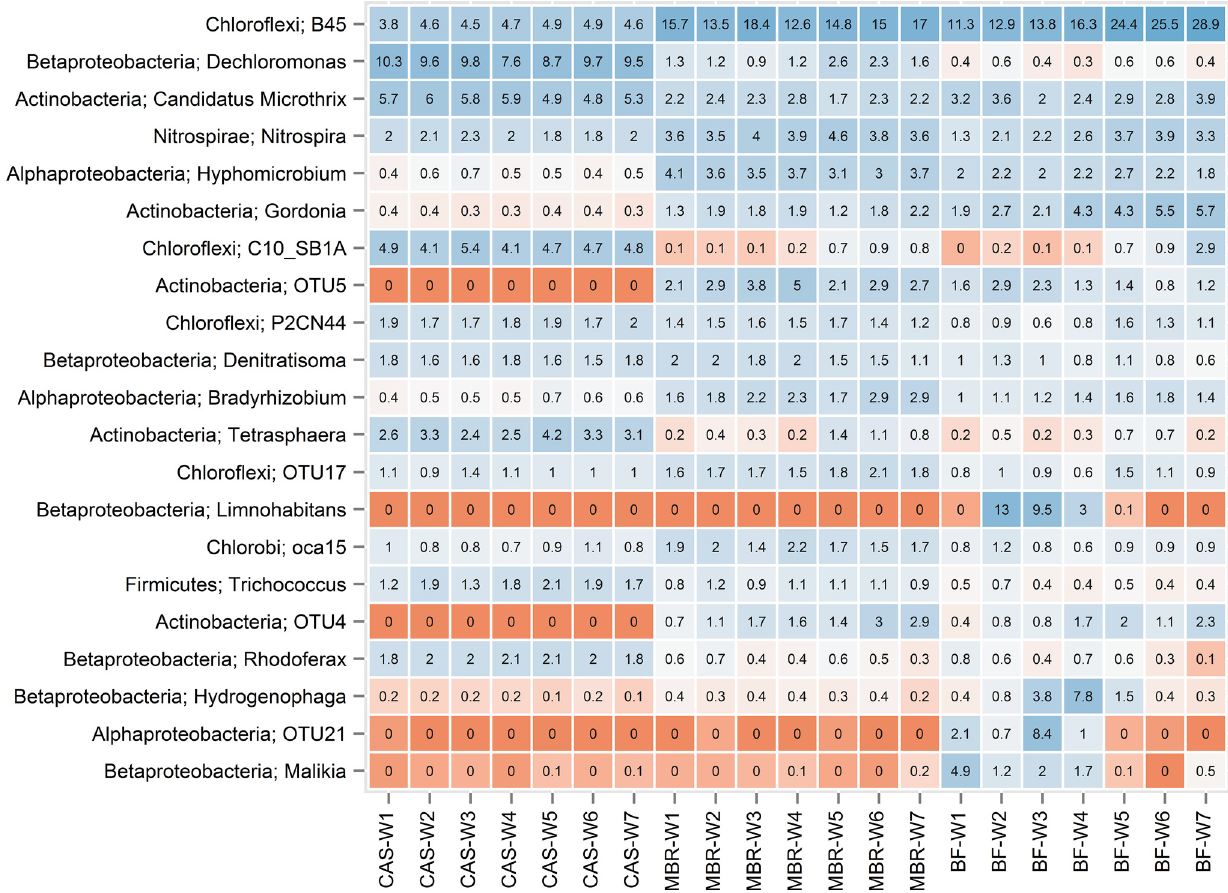
Fig 3. Heatmap showing the microbial composition represented as the 10 most abundant genera of CAS bulk sludge samples (CAS), MBR bulk sludge samples (MBR) and biofilm samples (BF), combined yielding 21 genera. The OTU number is given if it was not classified to the genus level with the MiDAS taxonomy. The data is visualised as a table with underlying colours showing changes and numbers showing the relative read abundances. W1-7 indicate the sampling time (in weeks).